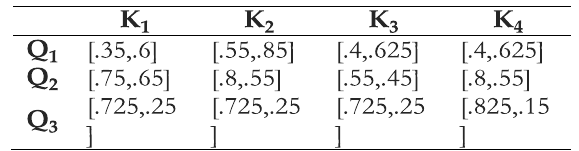
Table 2. Transformed decision